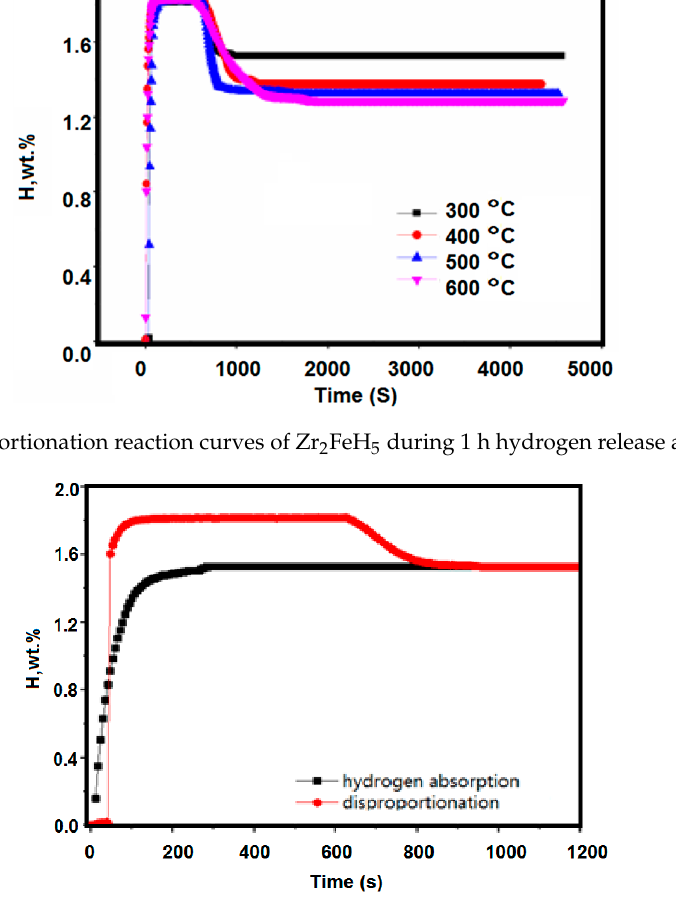
Figure 8. Kinetic curves of hydrogen absorption at 300 °C under hydrogen pressure of 0.1 MPa after activation of the alloy at 400 °C (black line); the disproportionation performance test is 300 °C (red line).